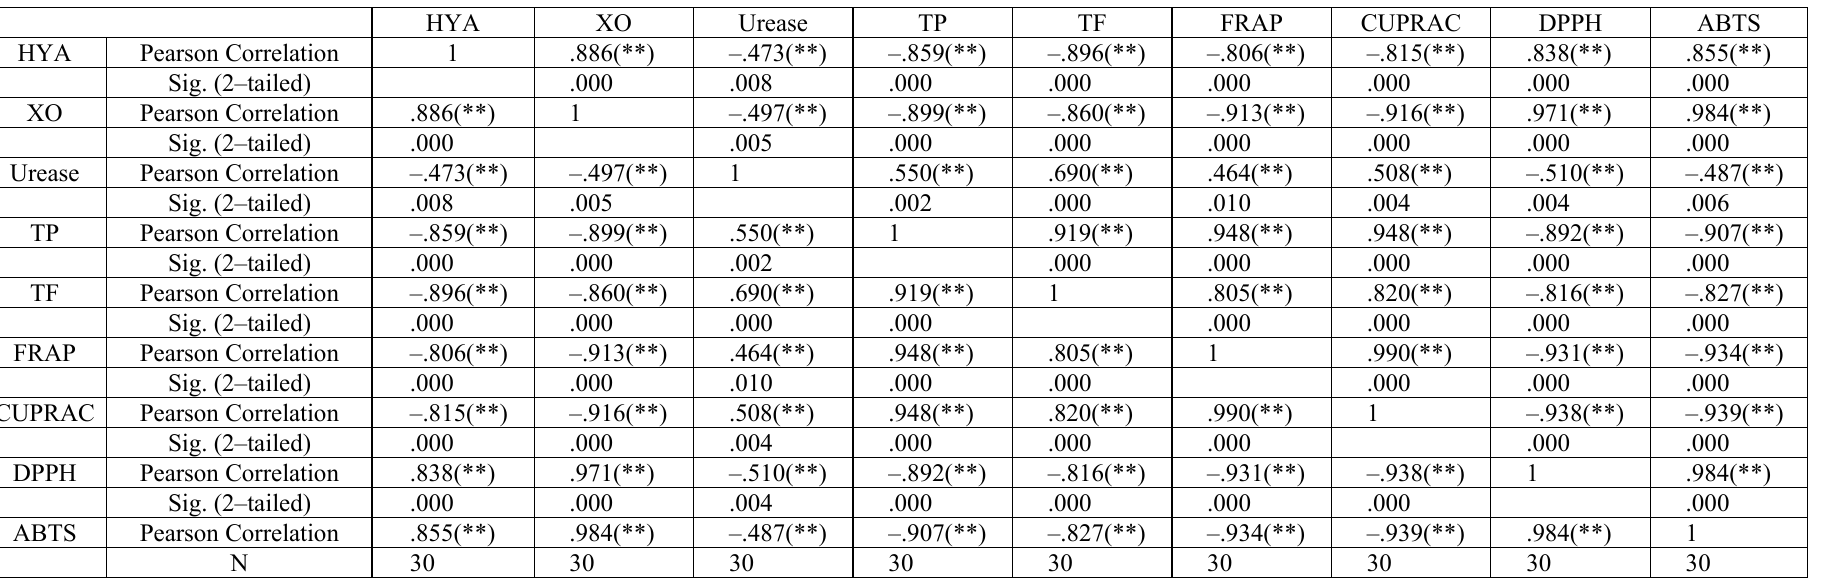
Table 3. Correlation coefficients of each